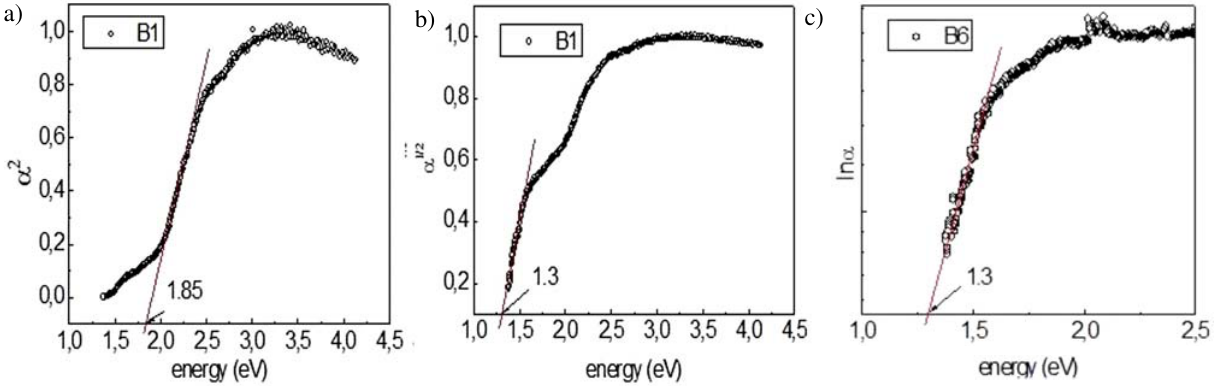
Figure 3. Raman spectra of the samples ZC31/4, ZC11/4, ZC13/4, ZC31/8, ZC11/8, ZC13/8 compared with the spectra of pure hematite and ZnO.